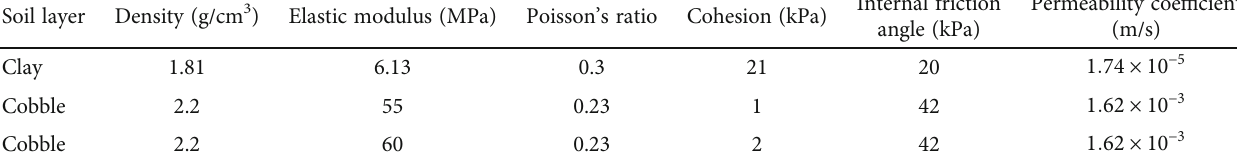
Table 1: Calculation parameters.